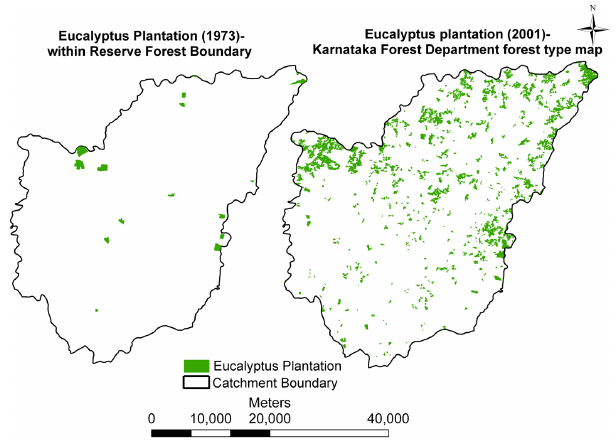
Figure 4. Change in eucalyptus area in Arkavathy Basin between 1973 and